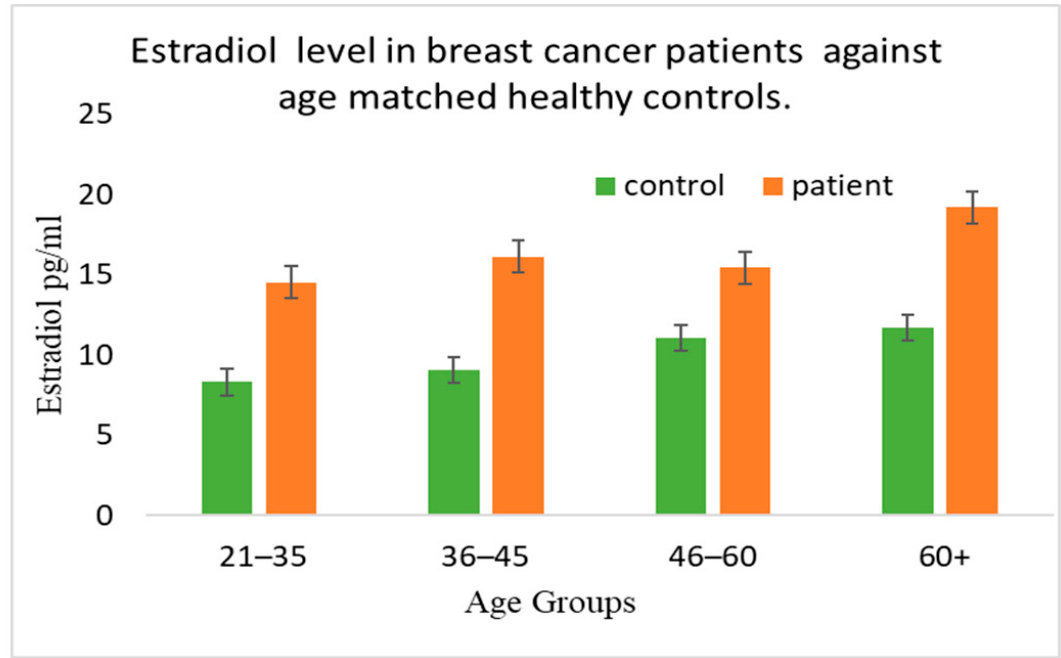
Figure 5. Overall expression of estradiol among breast cancer patients (Average RE = 16.31, n = 28, SD = 7.0, SEM = 1.32) and healthy control (Average = 10, n = 28, SD = 2.17) df = 1, p -value < 0.00001.